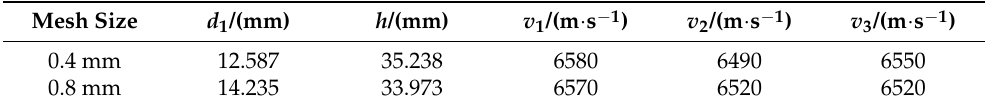
Table 4. Characteristic parameters of debris clouds under different mesh sizes by node separation method.